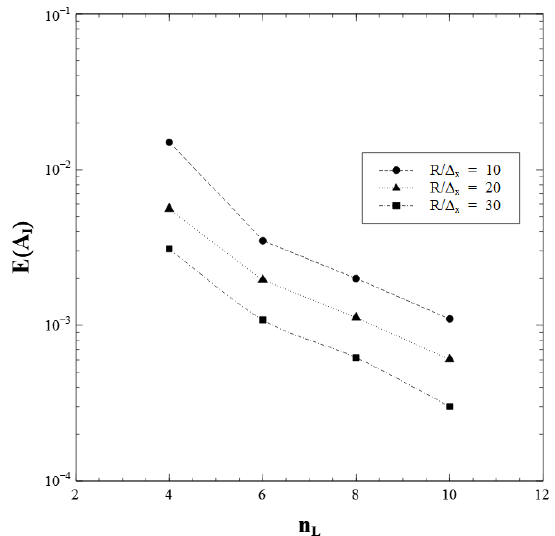
Figure 7. Relative interfacial area errors averaged along a circular interface as a function of n L and the mesh